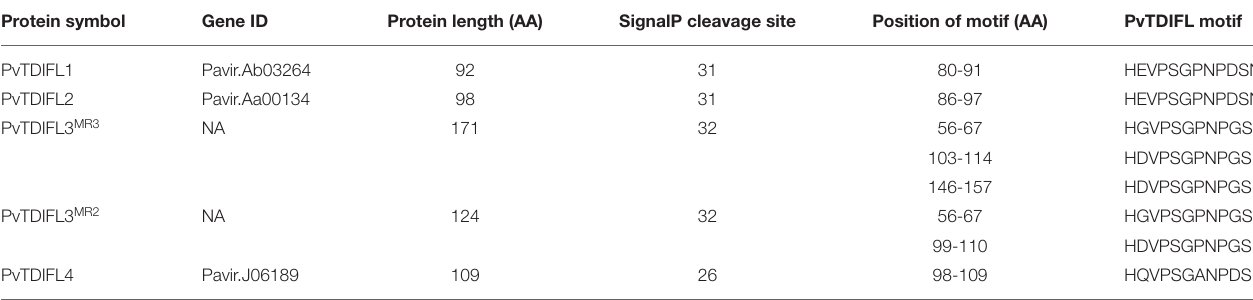
TABLE 1 | Information of PvTDIFL peptides used in this study. Protein symbol Gene ID Protein length